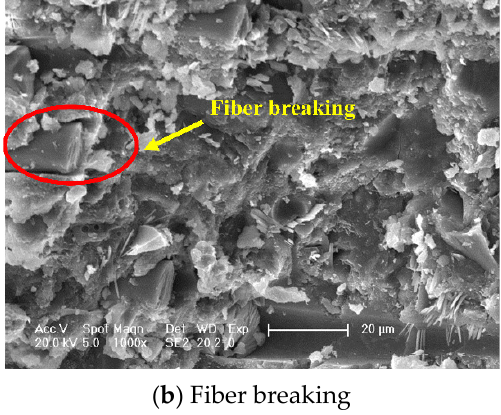
Figure 10. BFRPC